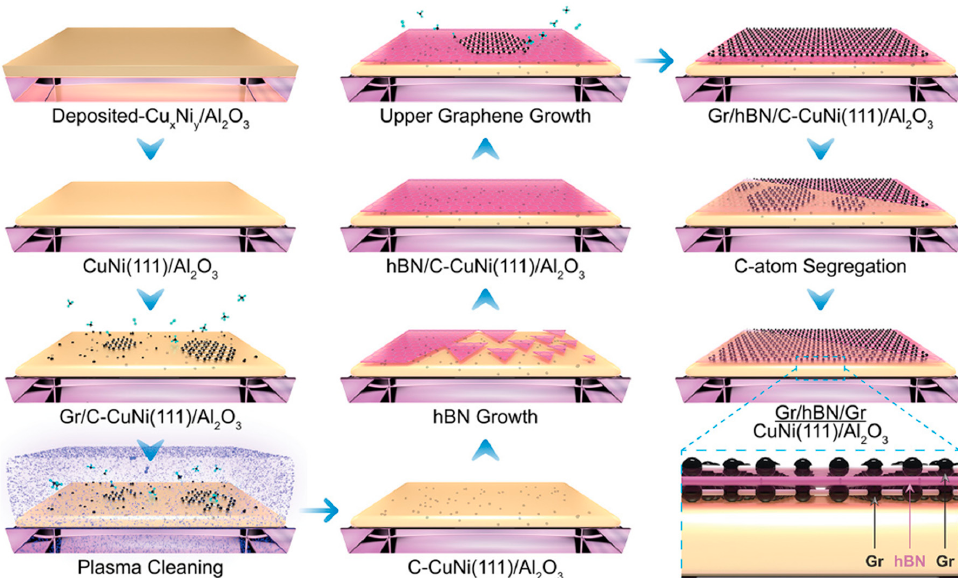
Figure 6. Schematics of the process of fabricating graphene/h-BN/graphene 2D vdWH by CVD method. Adapted with permission from [81]. Copyright © 2022 The Authors.